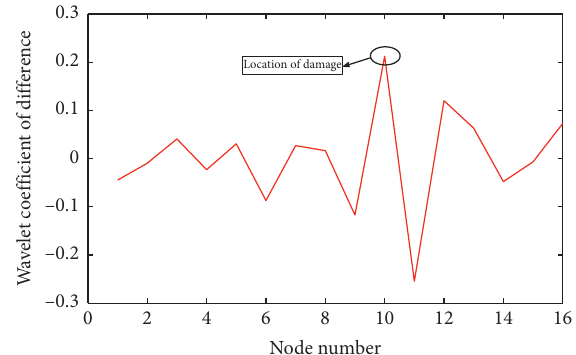
Figure 24: Wavelet coefficient difference for 6% damage in section 10.